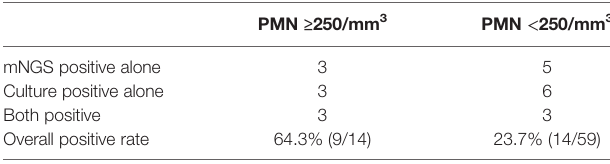
TABLE 2 | The positive results of mNGS and culture between patients with different PMN count